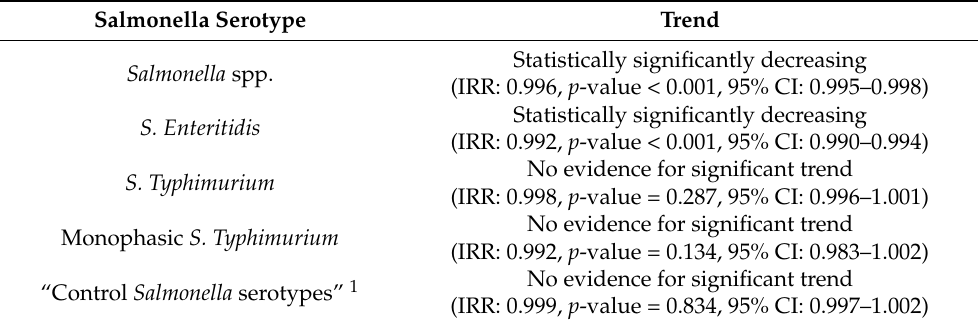
Table 1. Trends of the number of Salmonella spp., S . Enteritidis , S. Typhimurium , monophasic S.